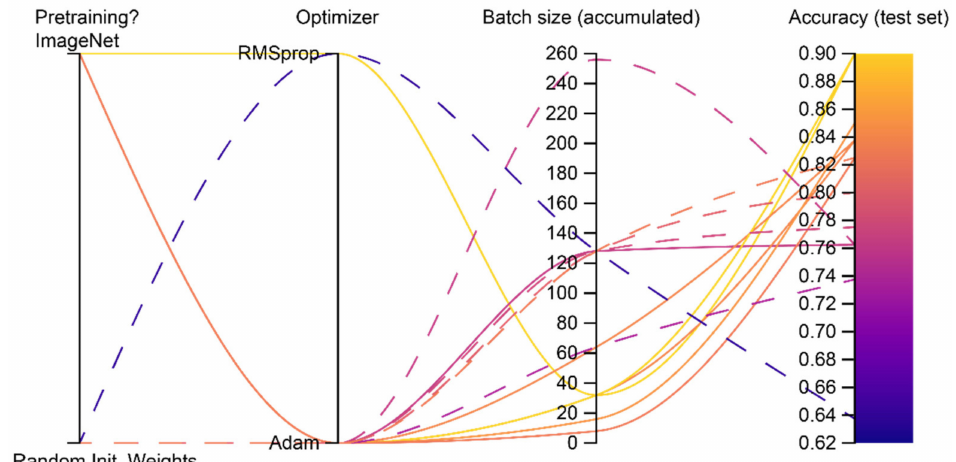
Figure 8. Experiment comparison by hyperparameter for ResNet50. This image shows some of the hyperparameters tested, as well as the accuracy in the test set. The solid lines show results for when the model is pretrained on the ImageNet and dashed lines show results for ResNet50 trained with randomly initialized weights.